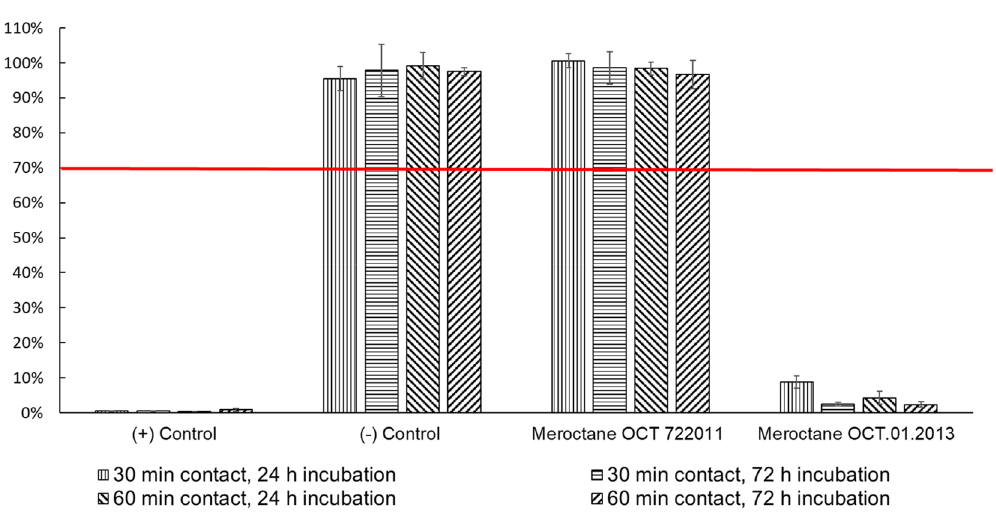
Figure 3. Cytotoxicity evaluation of MEROCTANE batches OCT 722011 and OCT.01.2013. Samples with ≤ 70% viability were considered cytotoxic (ISO 10993-5:2009). PFO batch OCT 722011 was distributed and used in Spain, no acute toxic cases were reported. PFO batch OCT.01.2013 was distributed in Chile causing acute toxicity in